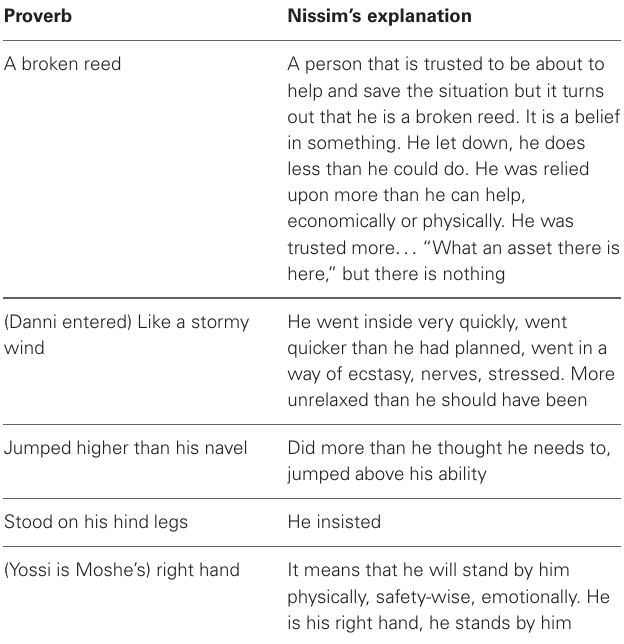
Table 4 | Examples of Nissim’s proverb explanation.